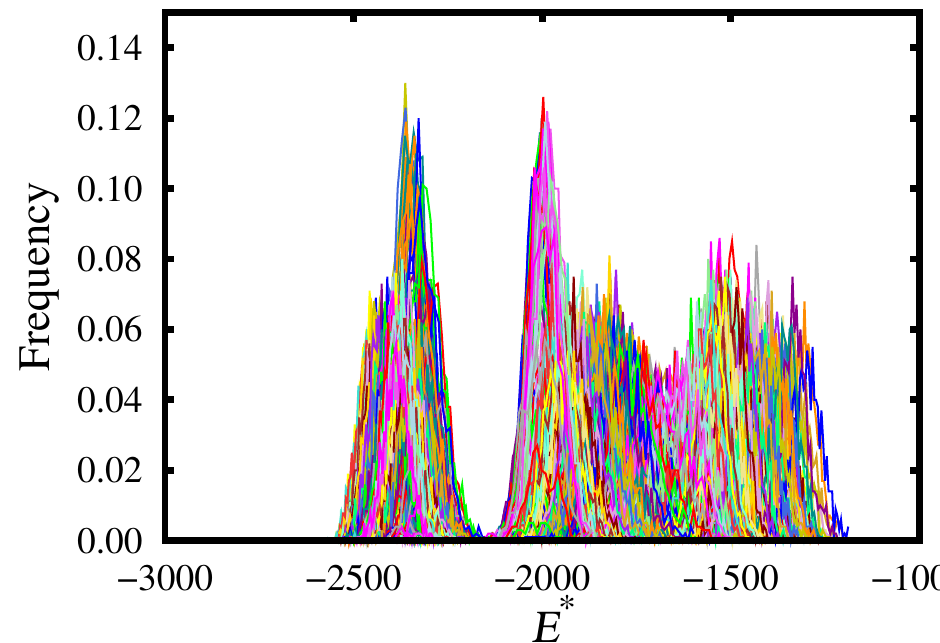
Figure 8. Replica-exchange energy histograms for the upward